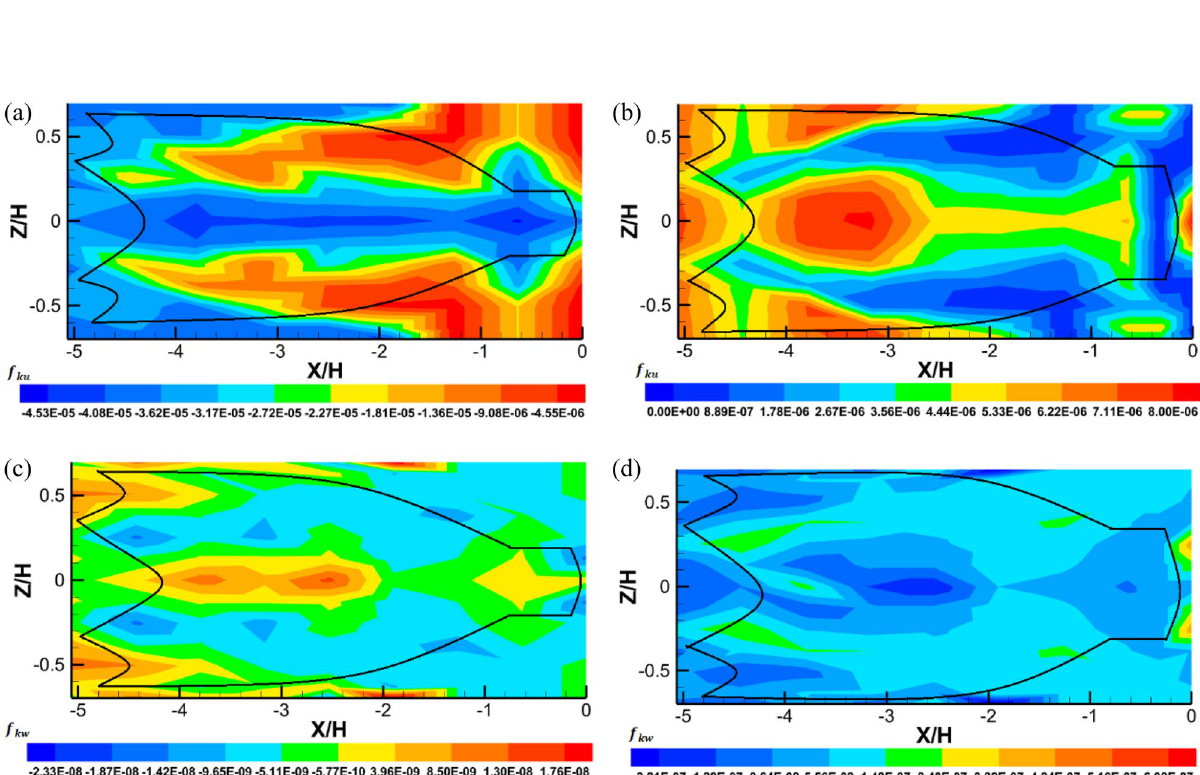
Figure 10. The gradient of turbulent kinetic energy flux components of the flow field inside and around midwater trawl net: Trawl without catch ( a and c ) and Trawl with catch ( b and d